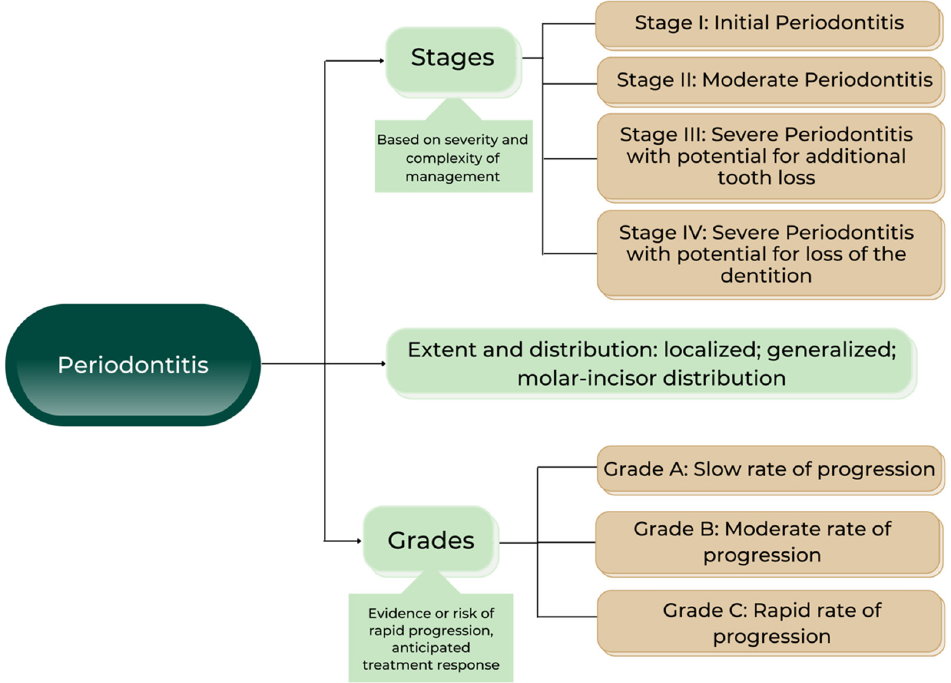
Figure 3. Classification of periodontitis